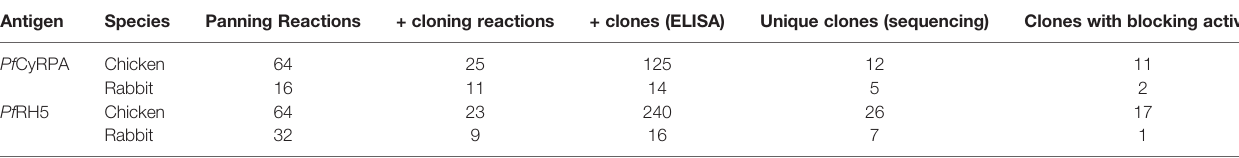
TABLE 1 | Summary of P. falciparum RH5 and CyRPA monoclonal antibody generation. Antigen Species Panning Reactions